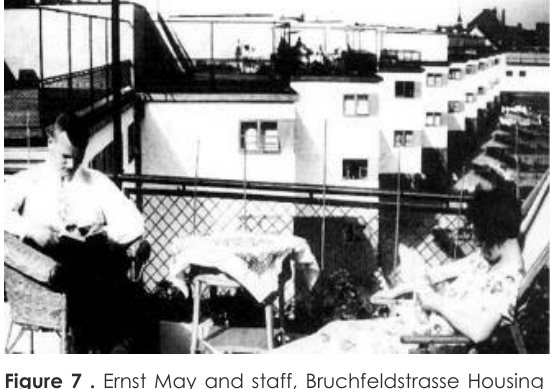
Figure 7 . Ernst May and staff, Bruchfeldstrasse Housing 1926, The utopian ideas implied in modernist housing can be seen even more clearly in Ernst May’s Siedlungen in Frankfurt ,May’s emphasis on the centrality of the community facility is clearly illustrated. (Lane,